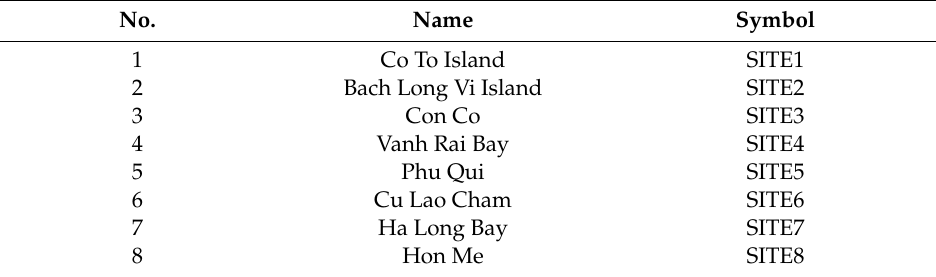
Table 2. List of 10 potential